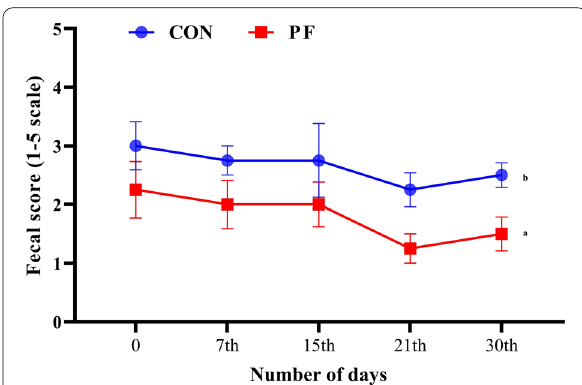
Fig. 2 Fecal score of Murrah buffalo calves supplemented with probiotics as compared to control group (significance: T D 0.193; T D 0.992). Basal diet with no supplementation (CON), = × = supplemented with L. reuteri